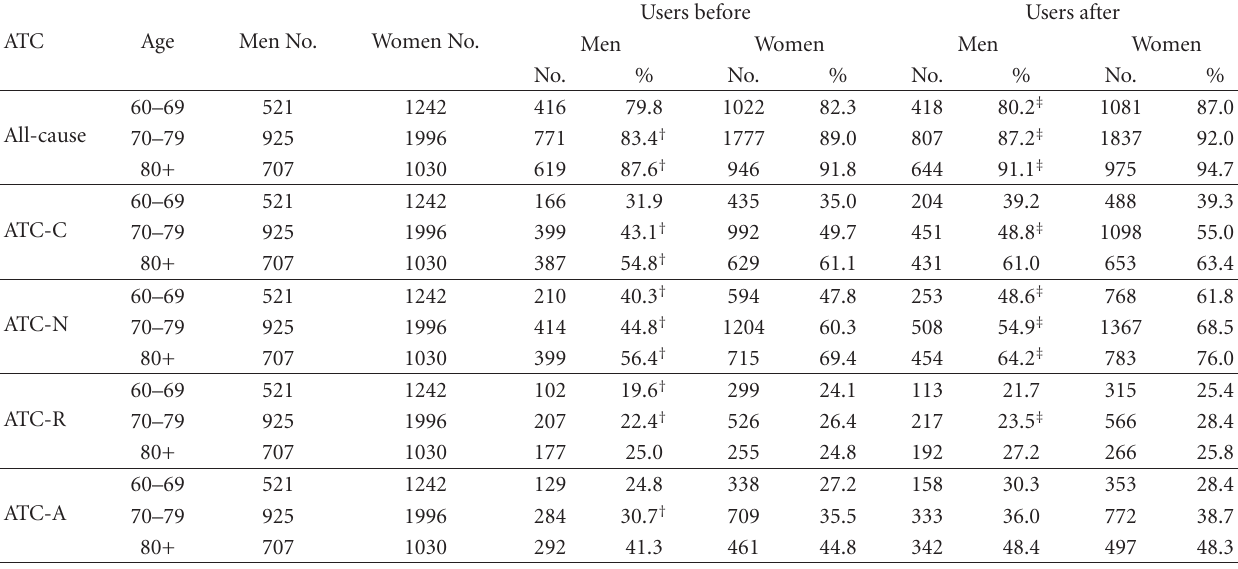
Table 1: The frequency of all-cause and system-specific medication use within 1 year before and 1 year after widowhood. Users before Users after ATC Age Men No. Women No. Men Women Men Women